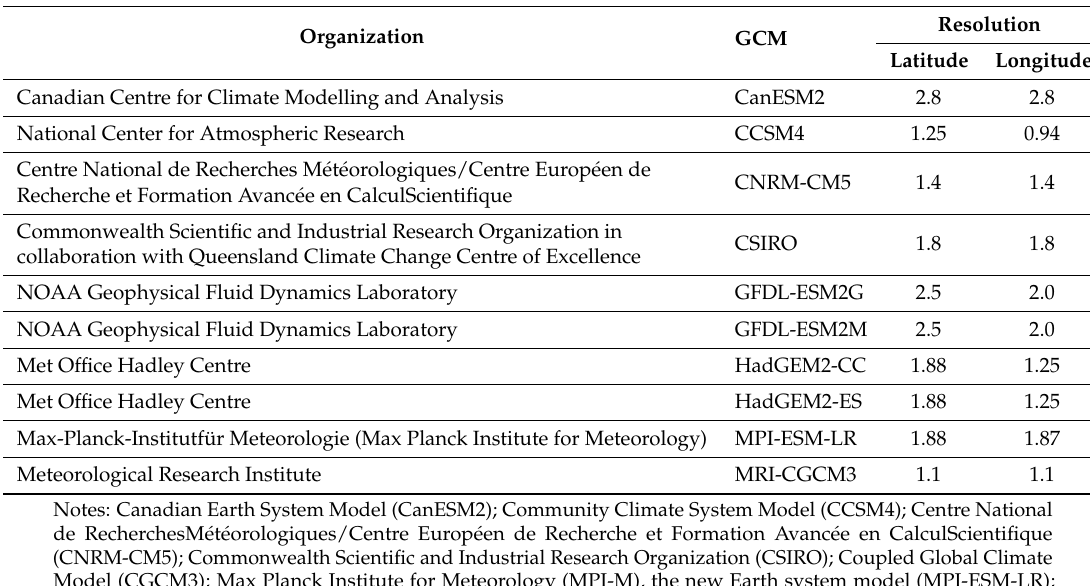
Table 2. List of Global Climate Models used in this